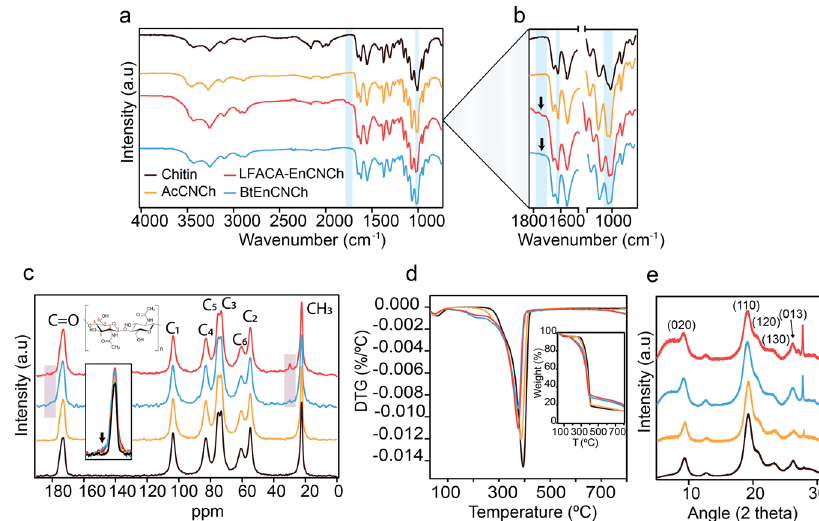
Fig. 4 Nanochitin physicochemical characterization. a FTIR spectra of α -chitin (black line), CNCh produced by oxidative cleavage of α -Chitin with LFACA- LPMO (LFACA-EnCNCh, red line), Bt LPMO ( Bt EnCNCh, blue line) and hydrochloric acid (AcCNCh, yellow line). Spectra from 4000 to 750 cm − 1 . b details of the signi fi cant incipient peaks of CNCh at 1740 cm − 1 , 1621 cm − 1 , and 1030 cm − 1 . c CP/MAS 13 C NMR spectra of α -chitin (black line), LFACA-EnCNCh (red line) produced with LFACA-LPMO enzymatic oxidative cleavage, Bt EnCNCh (blue line) produced with extant Bt LPMO oxidative cleavage and AcCNCh (yellow line) produced by hydrochloric acid hydrolysis. Inset in the region 178 ppm. d Thermogravimetric analysis curves of α -Chitin (black line), LFACA- EnCNCh (red line) produced with LFACA-LPMO enzymatic oxidative cleavage, Bt EnCNCh (blue line) produced with Bt LPMO enzymatic oxidative cleavage and AcCNCh (yellow line) produced by hydrochloric acid hydrolysis. Inset of weight loss curves and derivative from TGA curves. e XRD diffractogram for crystalline α -chitin (black line), LFACA-EnCNCh (red line), Bt EnCNCh (blue line), AcCNCh (yellow